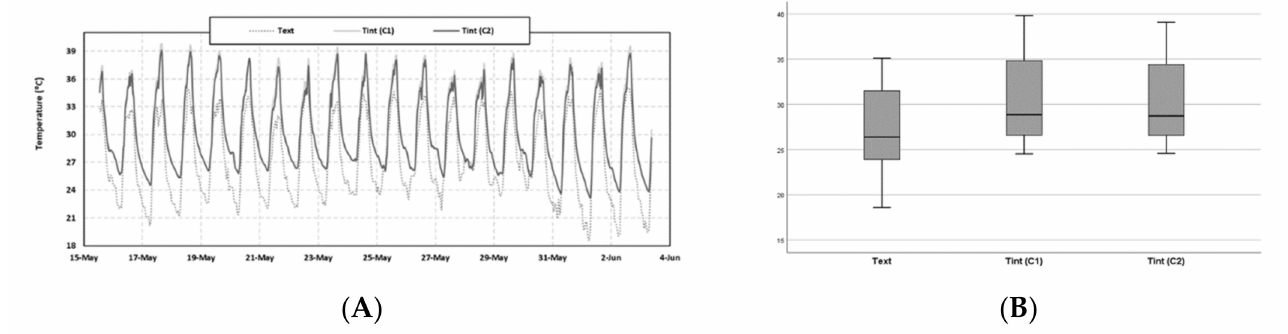
Figure 6. Air temperature between 15th May and 4th June, inside the two test cells and outside: ( A ) Variation in time; ( B ) Box-plot